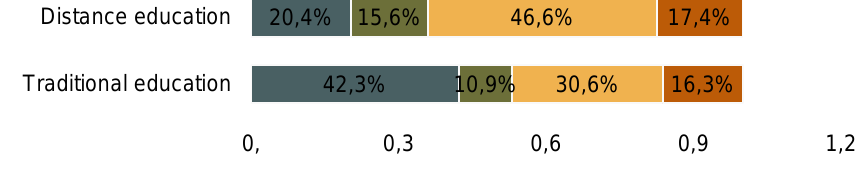
Fig. 5. Predominant Characteristics of work of Graduating